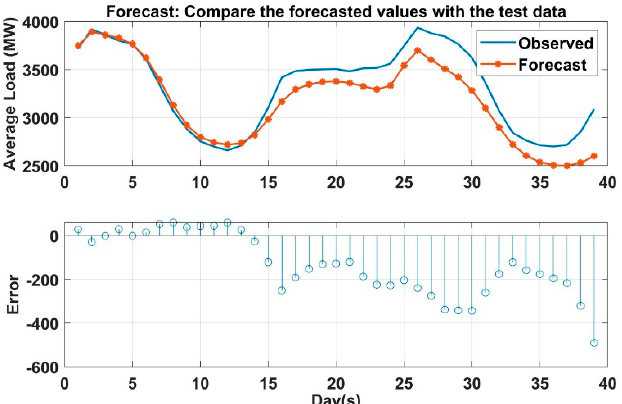
Figure 16. Per-day forecast of future time series.